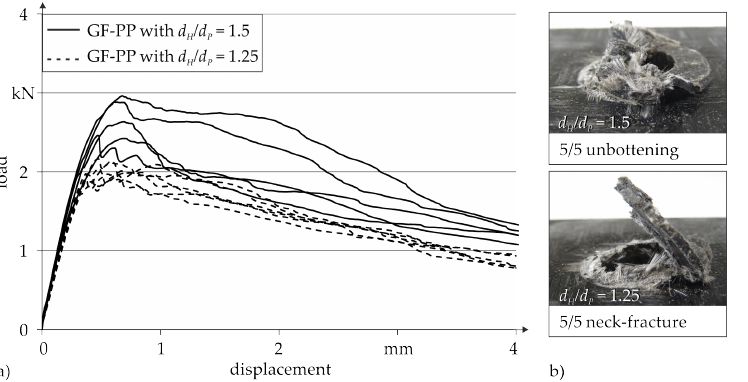
Figure 13. Thermoclinching: Results of single-lap shear tests under quasi-static load for thermo- clinched joints with different pilot hole to pin diameter ratios d H / d P : ( a ) load-displacement curves, ( b ) characteristic failure behaviour.